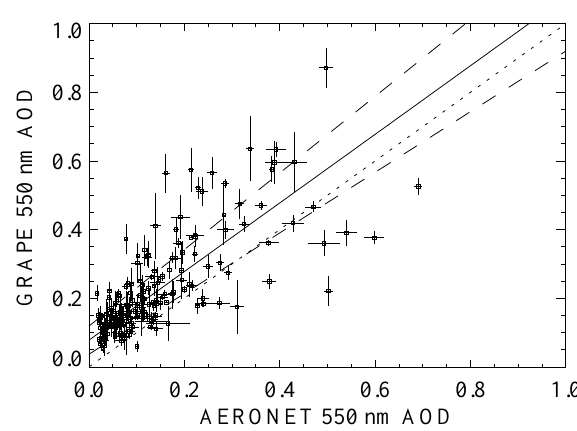
Fig. 2. Location of AERONET sites used for validation.